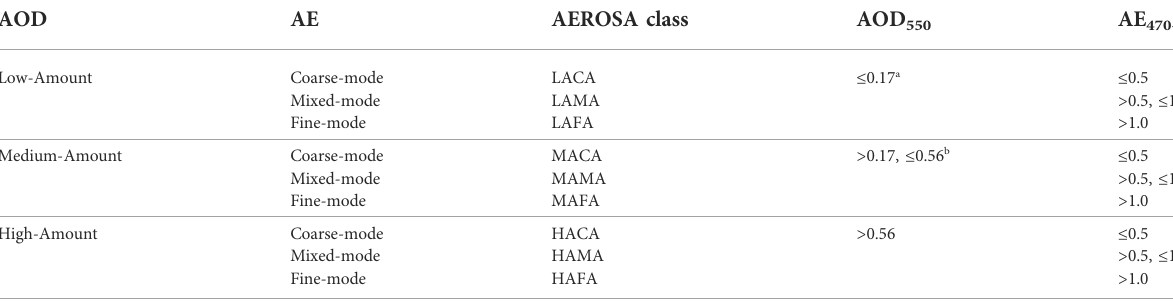
TABLE 4 AEROSA generic classes using MODIS DTB AOD and AE retrievals.